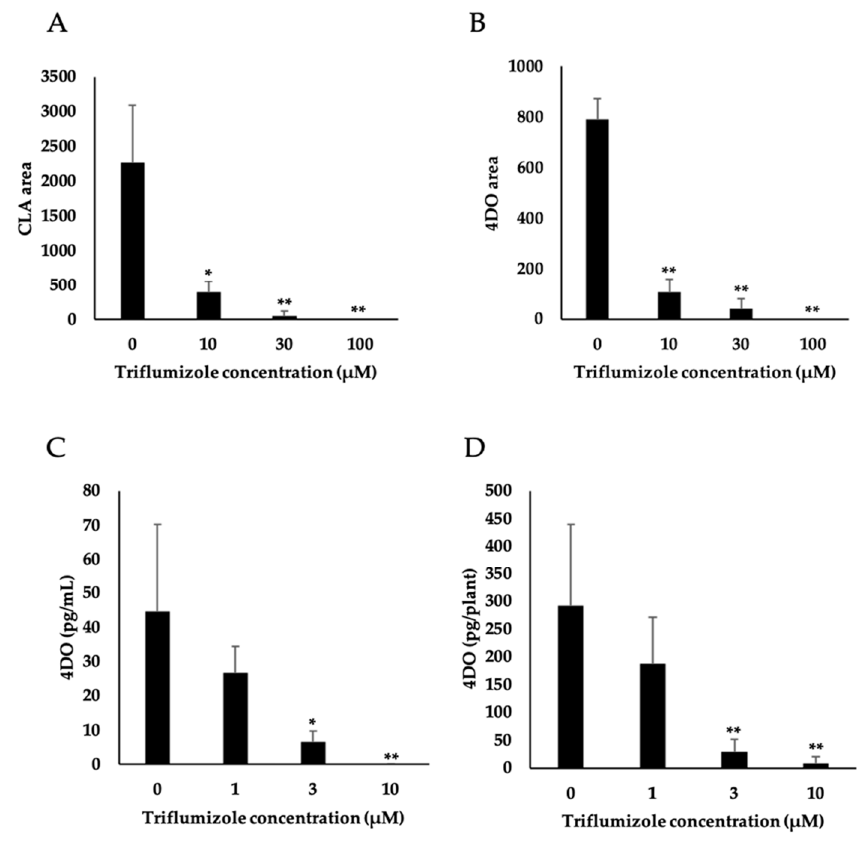
Figure 4. E ff ect of triflumizole on rice SL biosynthesis. E ff ect of triflumizole addition to Os900 expressed yeast microsomal protein on the levels of CLA ( A ) and 4DO ( B ) as determined by LC-MS / MS. The data are mean ± SD ( n = 3). Statistical di ff erence from the CLA ( A ) or 4DO ( B ) level of the 0 µ M triflumizole is indicated by * ( t test; 0.01 < p < 0.05) and ** (t test; p < 0.01). E ff ect of triflumizole addition to rice on 4DO levels in rice root exudates ( C ) and roots ( D ). The data are means ± SD ( n = 5). Statistically di ff erent from the 4DO level of the control plants ((*) = t test; 0.01 < p < 0.05, (**) = t test; p < 0.01).